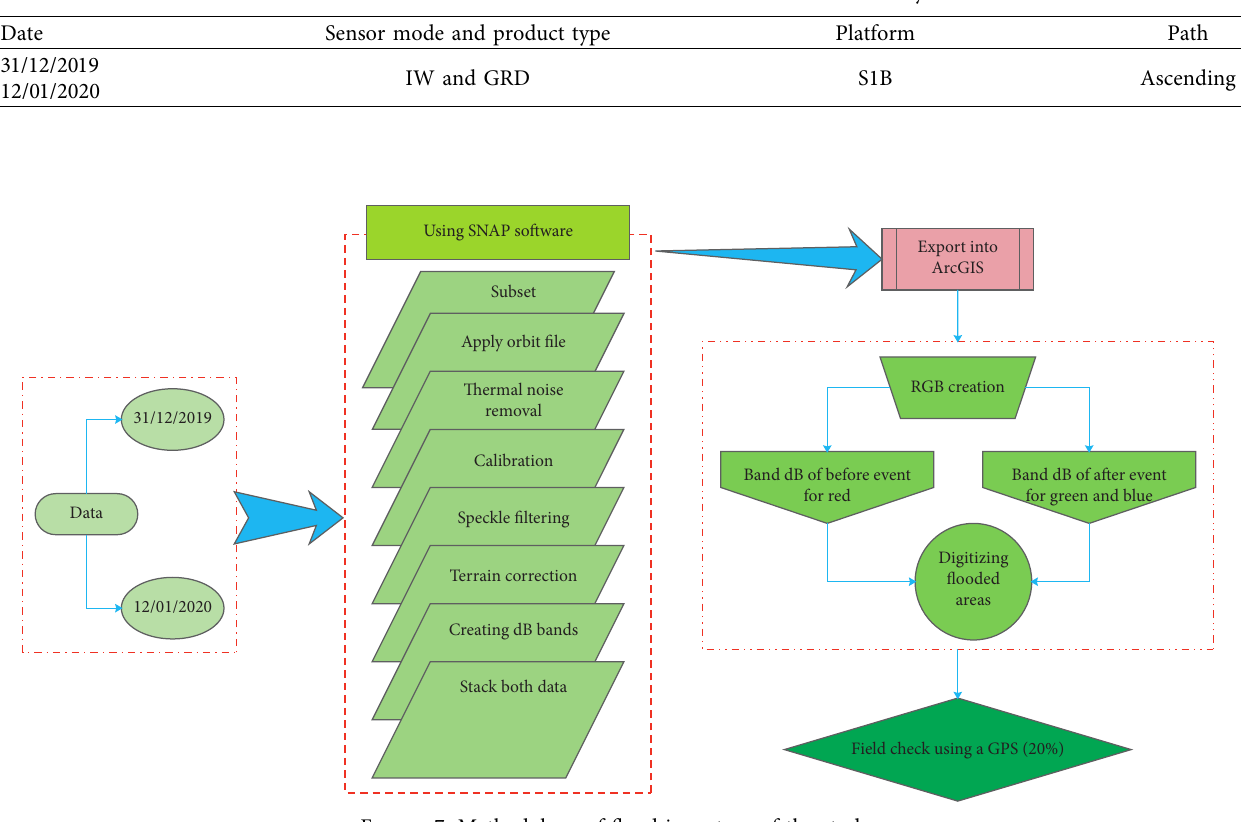
Table 2: Technical attributes of Sentinel-1 data for flood inventory.